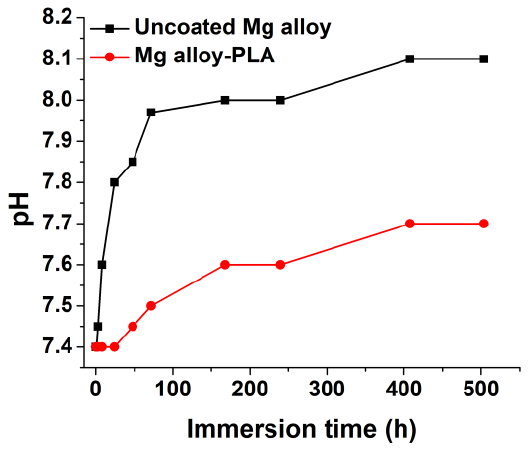
Figure 4. Evolution of the pH of the samples of uncoated Mg alloy and Mg-PLA, in SBF. After 3 h of immersion, the pH of the SBF solution increased. The development of a protective layer of Mg(OH) 2 on the surface of the Mg alloy explains this enhancement. The pH of the Mg alloy-PLA increased only after 48 h, which was mainly due to the deterioration of the coating and ion penetration into the Mg